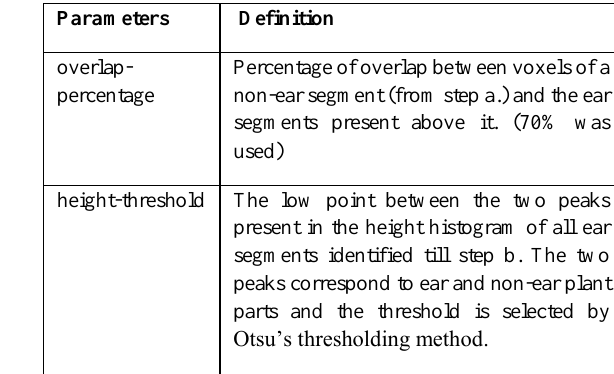
Table 3 Parameters used for the ear